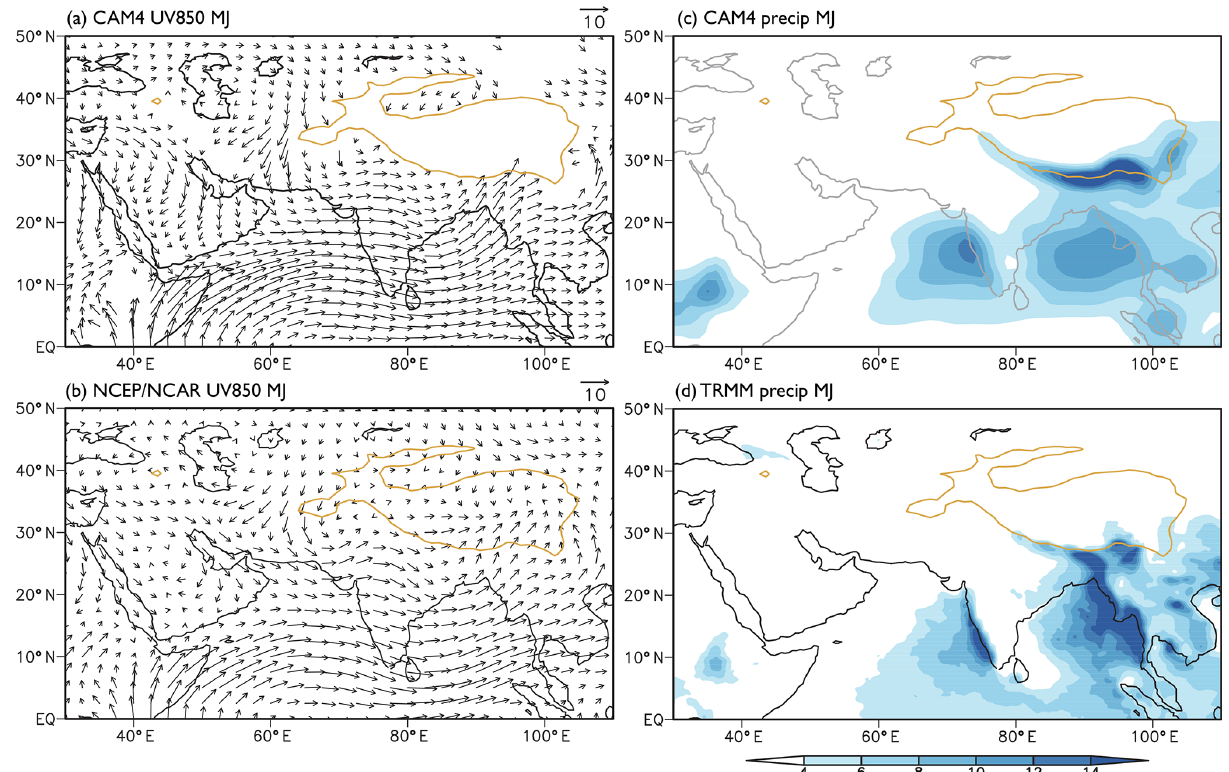
Figure 3. Averaged 850hPa wind vectors (ms − 1 ) over the Indian monsoon region for May and June in CAM4 (a) and in National Centers for Environmental Prediction/National Center for Atmospheric Research (NCEP/NCAR) reanalysis data (b) ; and precipitation rates (mmday − 1 ) for May and June in CAM4 (c) and in Tropical Rainfall Measuring Mission (TRMM)-retrieved data (d) . Yellow line shows the profile of the Tibetan Plateau above